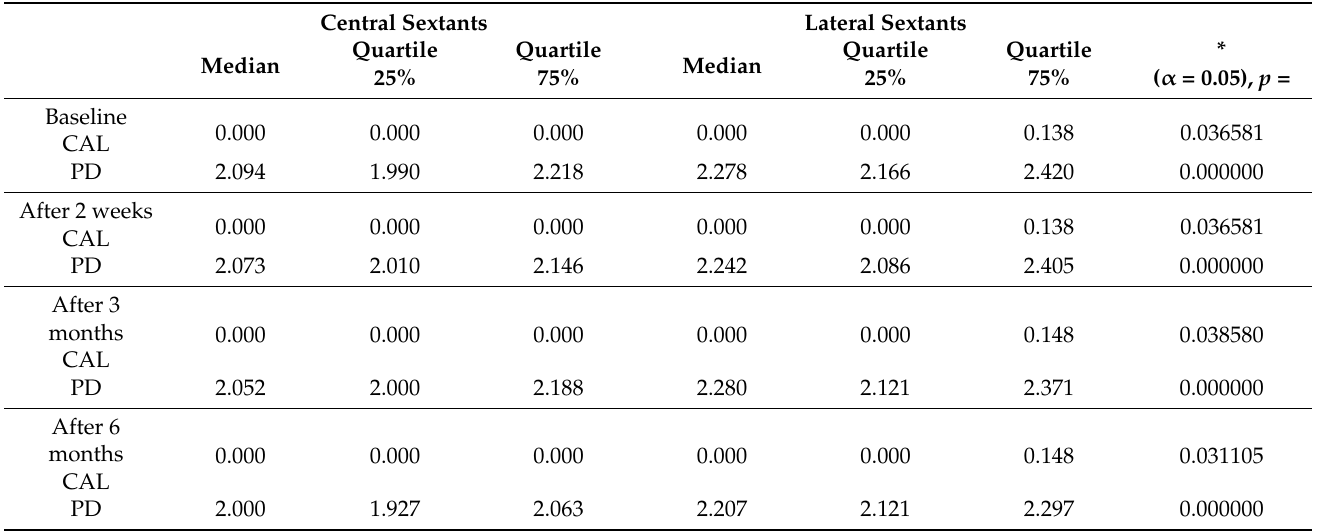
Table 3. Comparison of clinical parameters between central and lateral sextants in group II (ASTHMA). Central Sextants Lateral Sextants Quartile Quartile Quartile Median